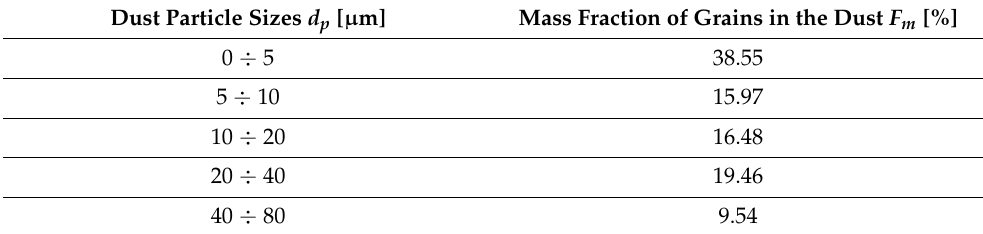
Table 1. Granulometric composition of the test dust PTC-D